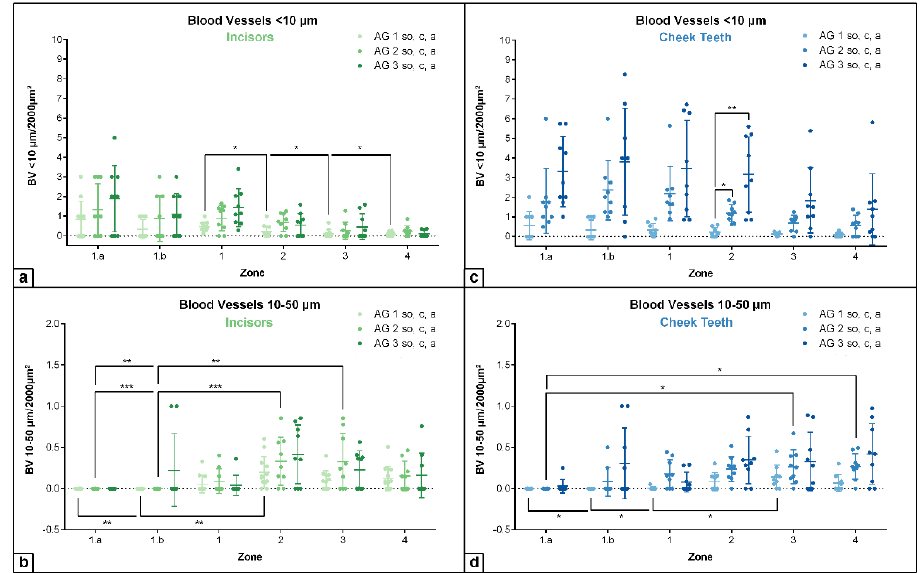
Figure 2. Dot-plot diagram showing the density of blood vessels (number per 2000 µm 2 ) with different diameters (<10 µm, 10 – 50 µm) of different age groups (AG 1 to 3) in different zones (zone 1.a to 4). Mean was presented as a central horizontal bar and the standard deviation as vertical whiskers. p -values: p ≤ 0.05 (*), p ≤ 0.01 (**), and p ≤ 0.001 (***). ( a ) Dot-plot diagram showing the density of blood vessels < 10 µm of incisors (green colors). ( b ) Dot-plot diagram showing the density of blood vessels 10 – 50 µm of incisors (green colors). ( c ) Dot-plot diagram showing the density of blood vessels <10 µm of cheek teeth (blue colors). ( d ) Dot-plot diagram showing the density of blood vessels 10 – 50 µm of cheek teeth (blue colors).